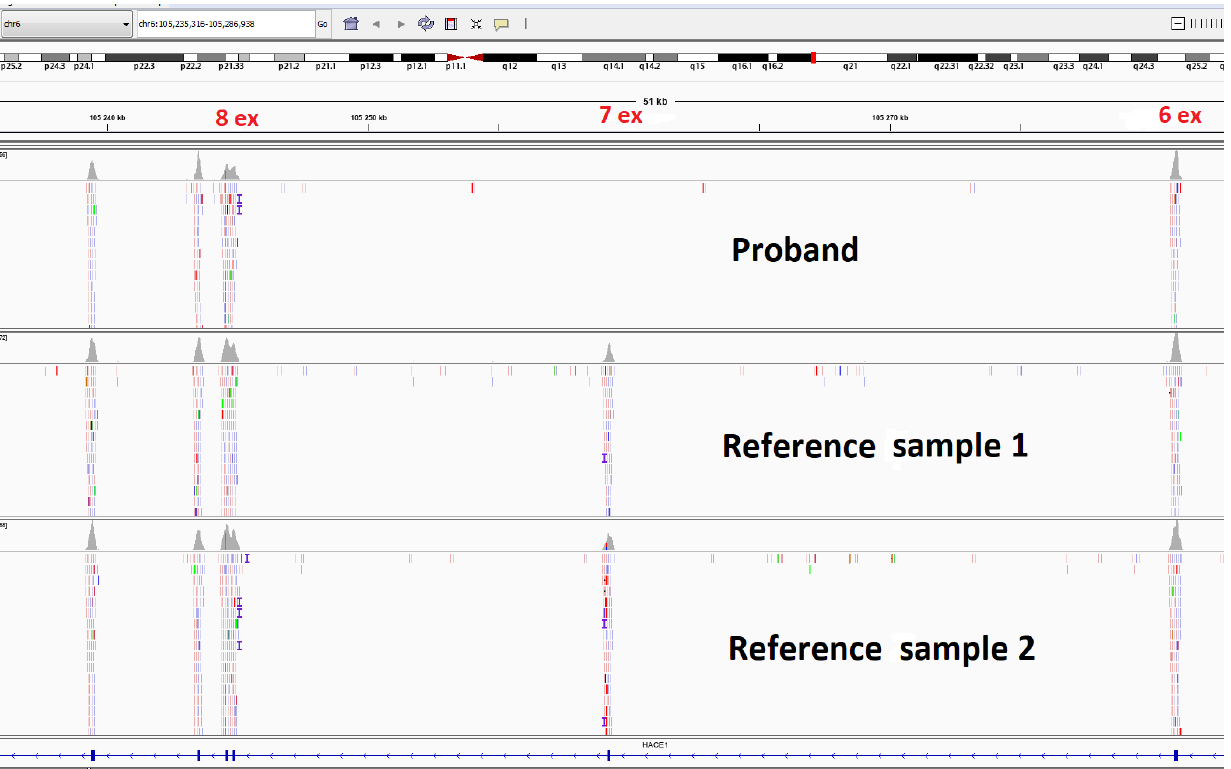
Figure 4. Molecular genetic testing of the patient by clinical exome sequencing and visualization of the homo/hemizygous deletion of HACE1 exon 7.